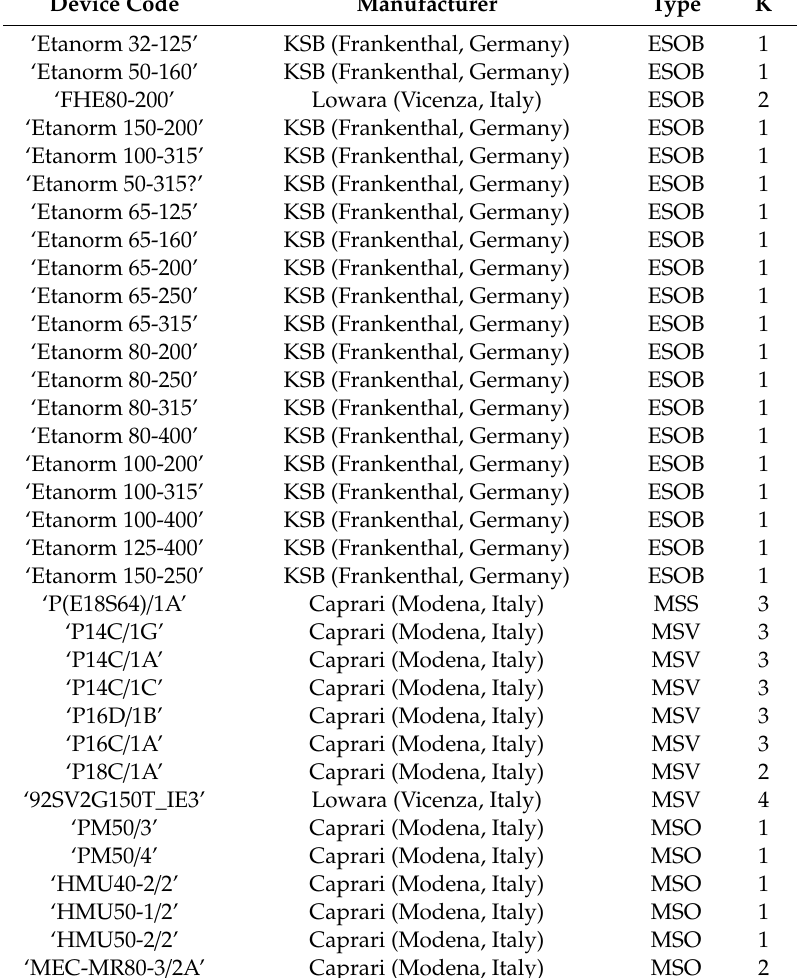
Table 1. Resume of Redawn database